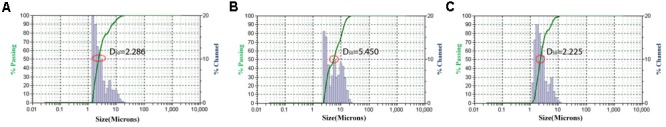
The effect of flocculation on starch granule size. (A) Particle size of starch granules in starch suspension before flocculation. (B) Particle size of starch granules in starch deposition after flocculation. (C) Particle size of starch granules in the supernatant after flocculation.